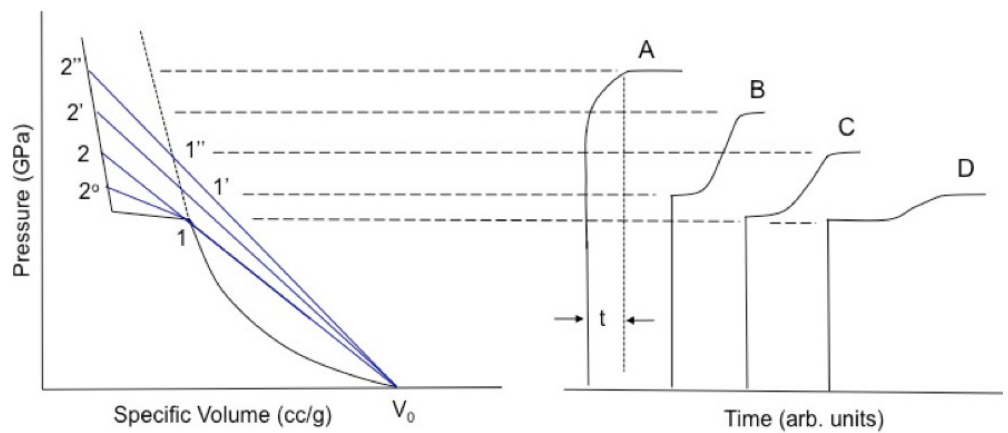
Figure 1. Shock-driven transitions such as chemical reaction or phase transformation that entail a reduction in volume can cause splitting of the initial wave. A transition with an onset at 1 on the principal Hugoniot will produce a waveform qualitatively similar to that of D. As the input stress is increased to 1’, 1”, etc., the temporal separation between the initial and reactive wave lessens (the plateaux on the right shorten in moving from D to B) until the transition is “overdriven” (as in A) and appears only as rounding in the initial wave. At sufficiently high input stress, even this rounding will disappear, and the transition will complete in the risetime of the lead shock. (reprinted with